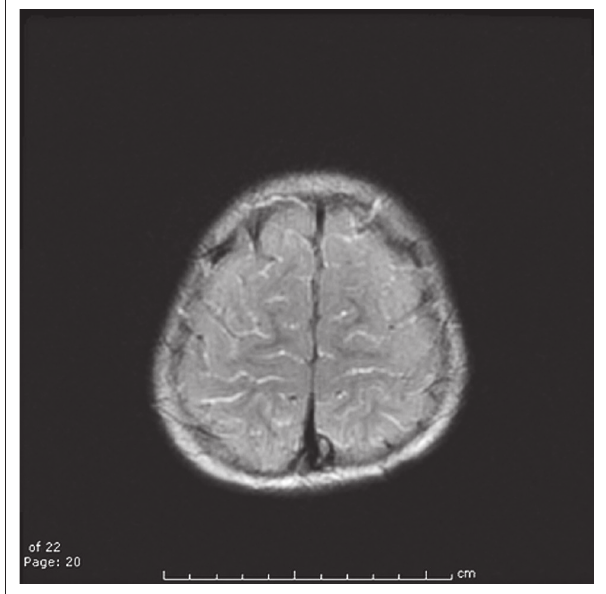
FLAIR MRI, fluid attenuation inversion recovery magnetic resonance imaging. FIGURE 2: T2-weighted FLAIR MRI sequences demonstrating the ivy sign, namely increased signal intensity in the bilateral subarachnoid spaces and perivascular spaces. This represents neovascularisation over the cerebral cortex via leptomeningeal anastomosis through collateral circulation that develops from the diffuse pial arterial network.